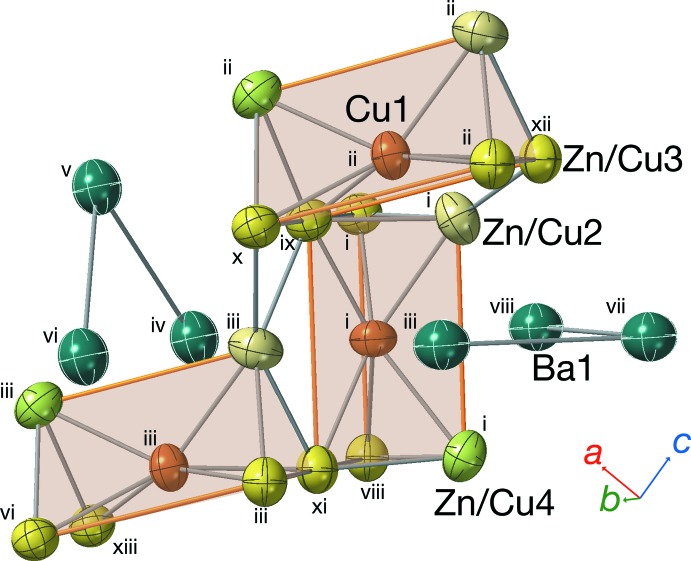
Arrangement of Cu1-centered Zn/Cu trigonal prisms and the Ba1 atoms. Symmetry codes: (i) x, y, z; (ii)  − x, 1 − y,  + z; (iii)  − x, 1 − y, − + z; (iv) x, y, −1 + z; (v) 1 − x,  + y, 1 − z; (vi) x, 1 + y, −1 + z; (vii) − + x,  − y,  − z; (viii)  − x, −y, − + z; (ix) x,  − y, z; (x) x, 1 + y, z; (xi)  − x,  + y, − + z; (xii)  − x,  + y,  + z; (xiii) x,  − y, −1 + z.